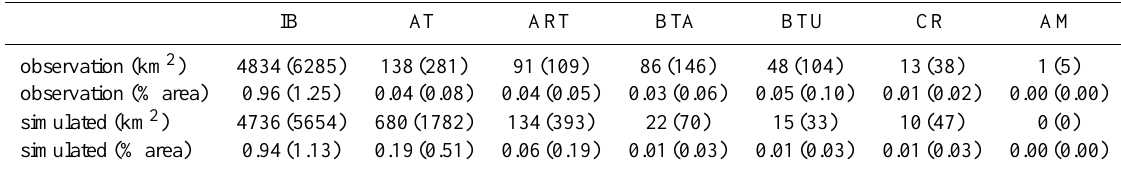
Fig. 4. Simulated C-storage in the organic topsoil layer (O horizon) newly implemented in LPJ. Table 4. Observed and simulated mean (standard deviation) area burned and burned percent of total ecoregion area over the time period 1986–2010 by